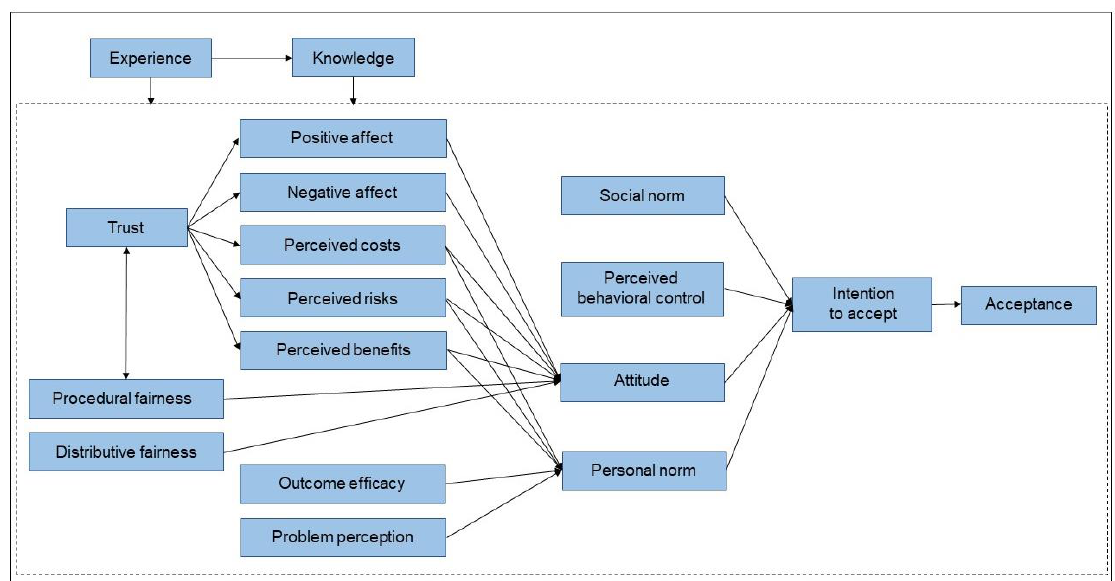
Figure 2. Schematic representation of the technology acceptance framework [17].